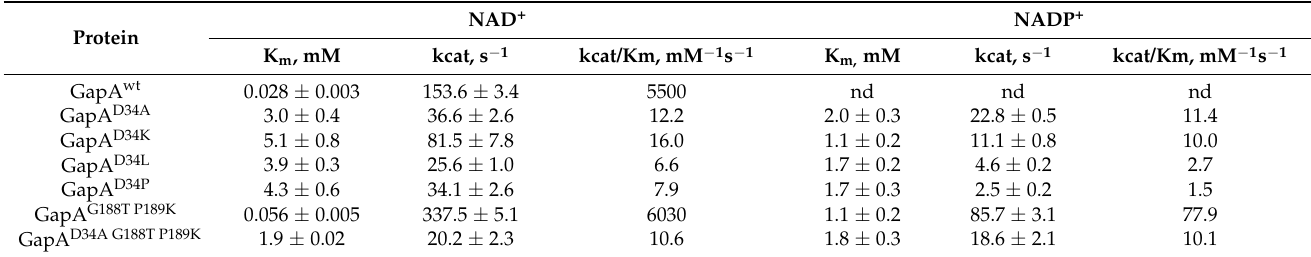
Table 5. Kinetic characteristics of GAPDHs.